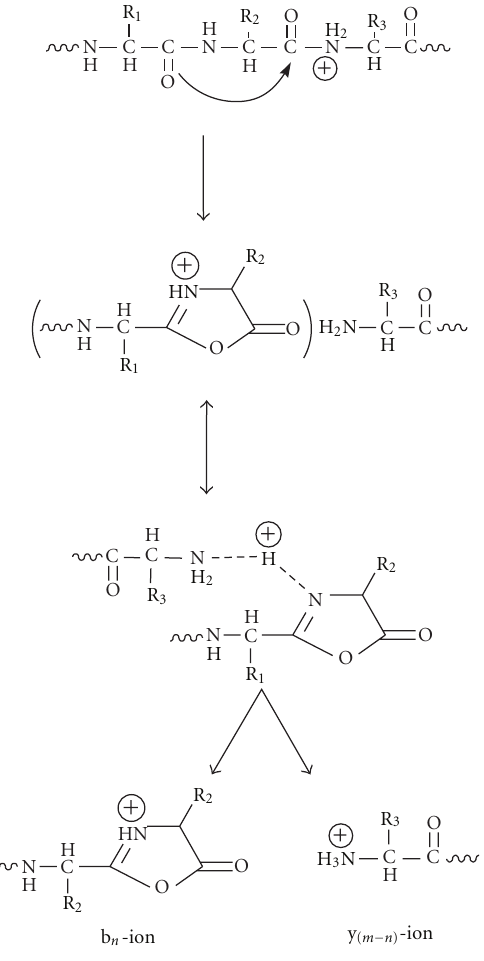
Scheme 2: A mechanism for the production of b n and y n